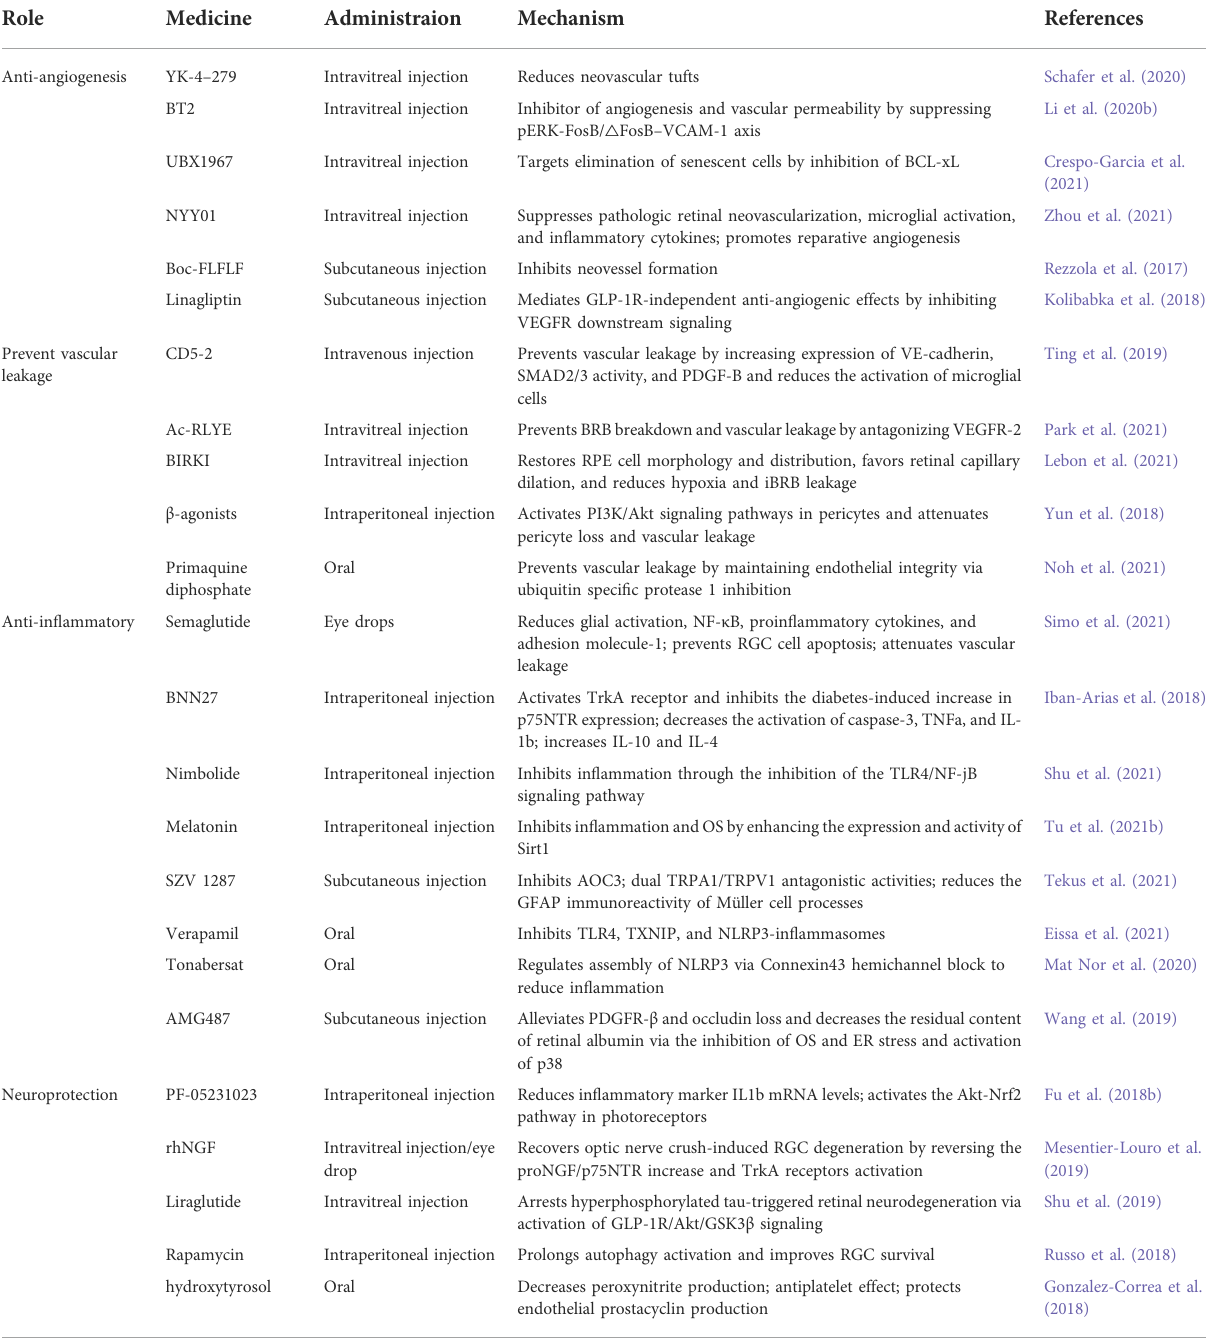
TABLE 5 Synthetic molecules in preclinical